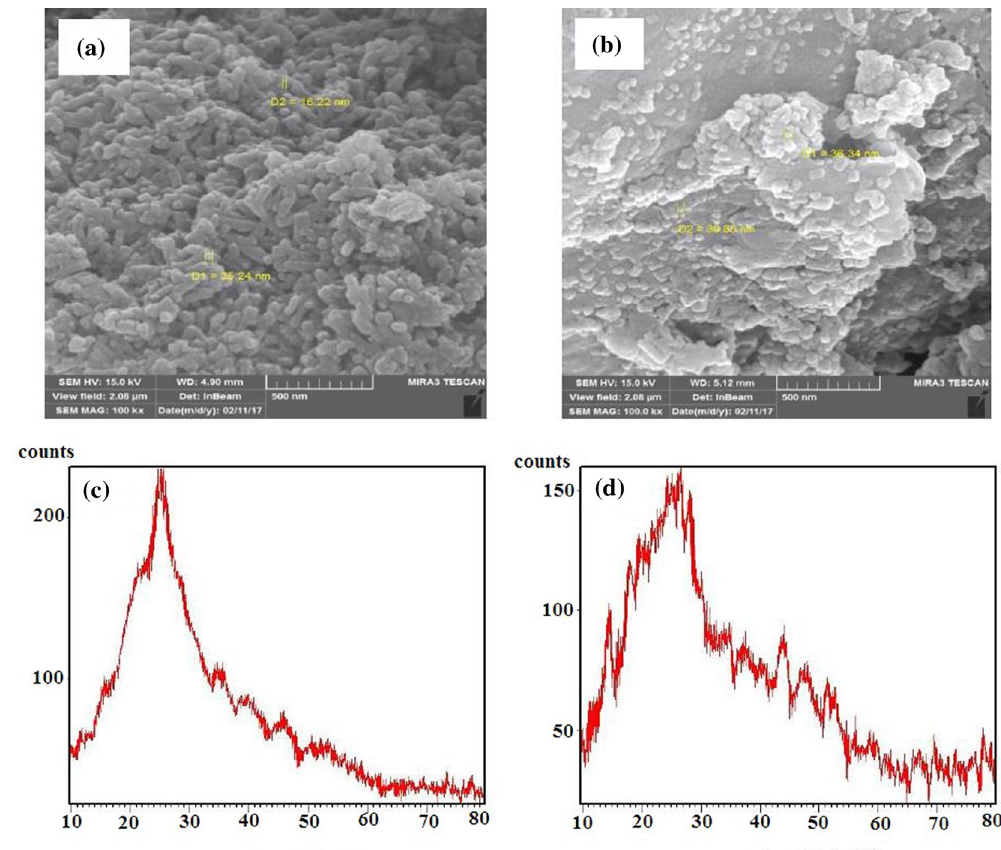
Figure 5. The SEM images ( A , B ) and XRD images ( C , D ) of the CdS@HPEc-g-PANi and mCdS@HPEc-g-PANi